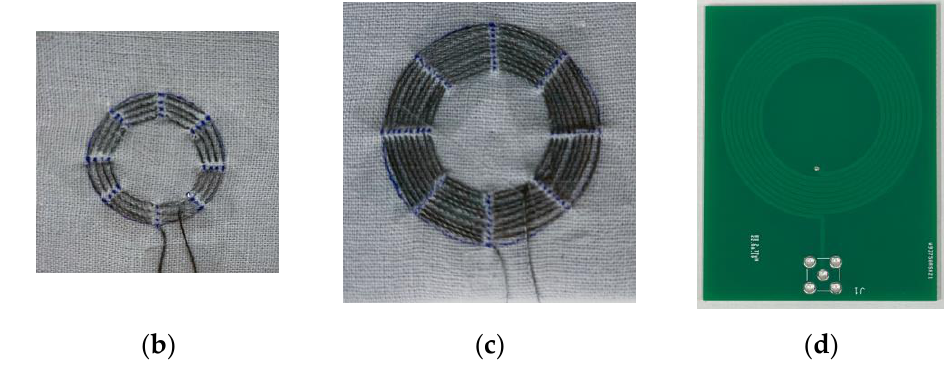
Figure 8. ( a ) TX Coil L tx ; ( b ) Textile Coil L t 0 ; ( c ) Textile Coil L t ; ( d ) RX coil L rx .